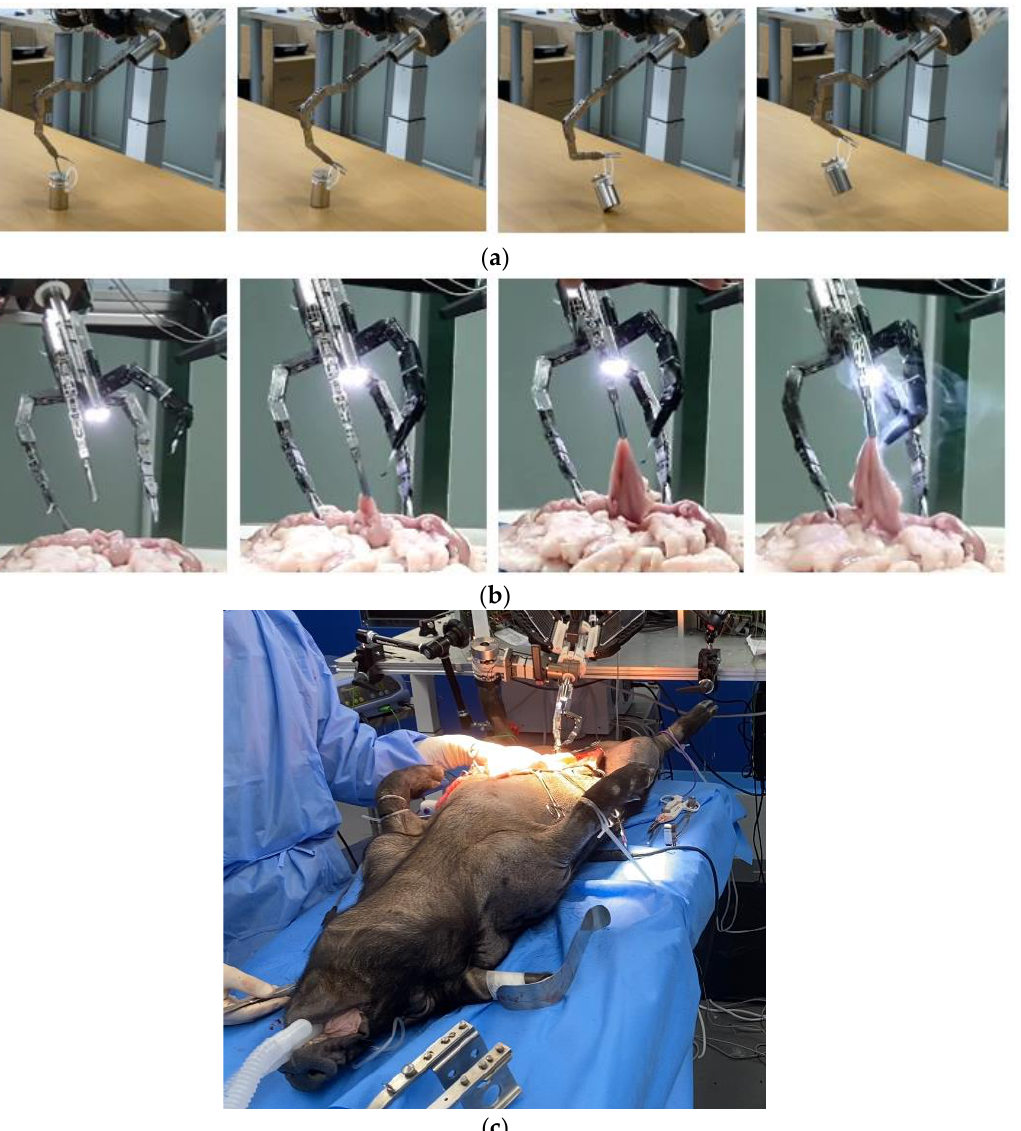
Figure 10. Motion tests: ( a ) load test for lifting weights; ( b ) tripe cutting motion test; ( c ) experiment on an animal (pig).